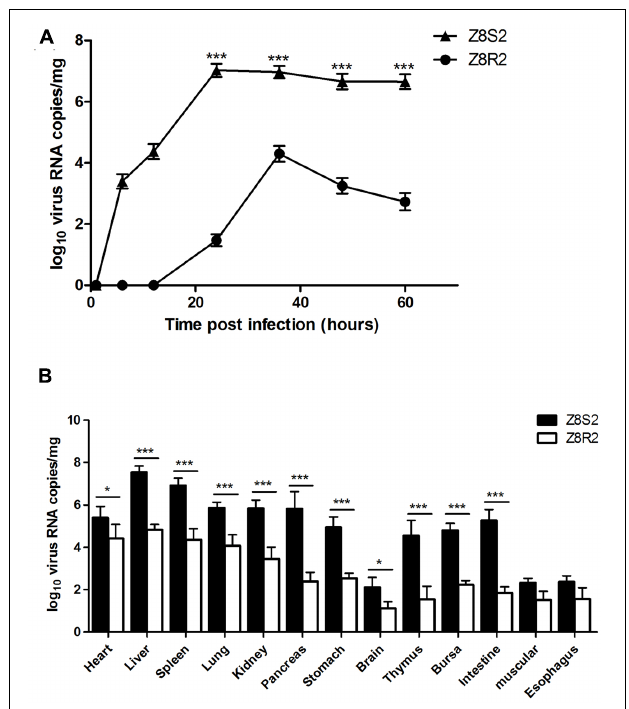
FIGURE 4 | Viral load in Z8S2 and Z8R2 groups of ducklings infected with DHAV-3. (A) RNA copy number in livers of ducklings between 1 and 60 h after infection. For group Z8S2, 3 live ducklings were used for 1 and 6 h, 5 for 12 h, and 5 dead ducklings for each sampling time between 24 and 60 h. For sample collection, ducklings dead between 22 and 24 h, 24 and 36 h, 36 and 48 h, and 48 and 60 h were recorded as those died at 24, 36, 48, and 60 h, respectively. For flock Z8R2, 5 live ducklings were used for each sampling time except 4 for 6 and 48 h. (B) RNA copy number in different organs of ducklings at 30 hpi. Five dead ducklings were used in group Z8S2, and 5 live ducklings were used in group Z8R2. Groups Z8S2 and Z8R2 were compared for statistical significant differences using two-way ANOVA followed by Student’s t -test. ∗ P < 0.05; ∗∗∗ P < 0.001.